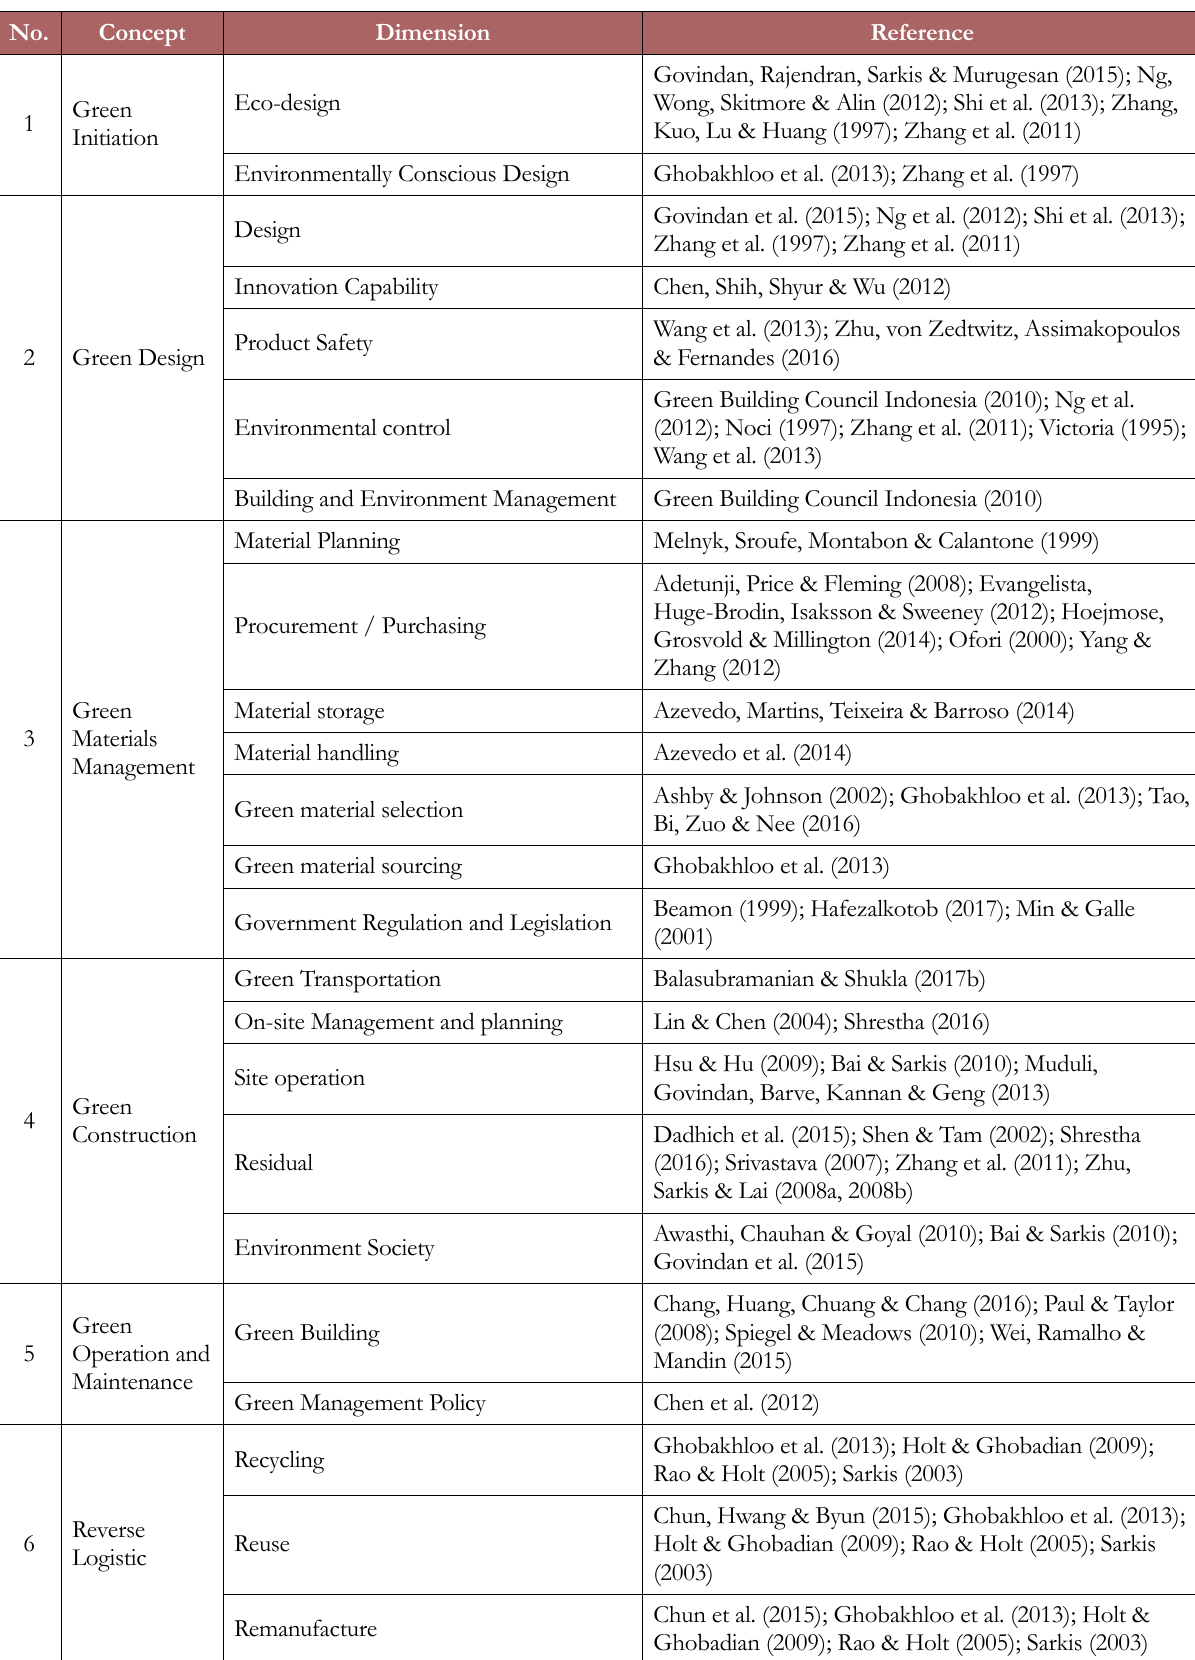
Table 1. Dimensions and Elements of GSCM in the Construction